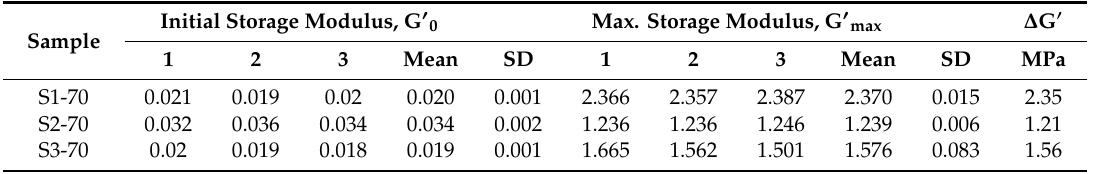
Table 2. The zero-field modulus (G (cid:48) 0 ) maximum modulus (G max ) and magneto-induced modulus ∆ G (cid:48) .